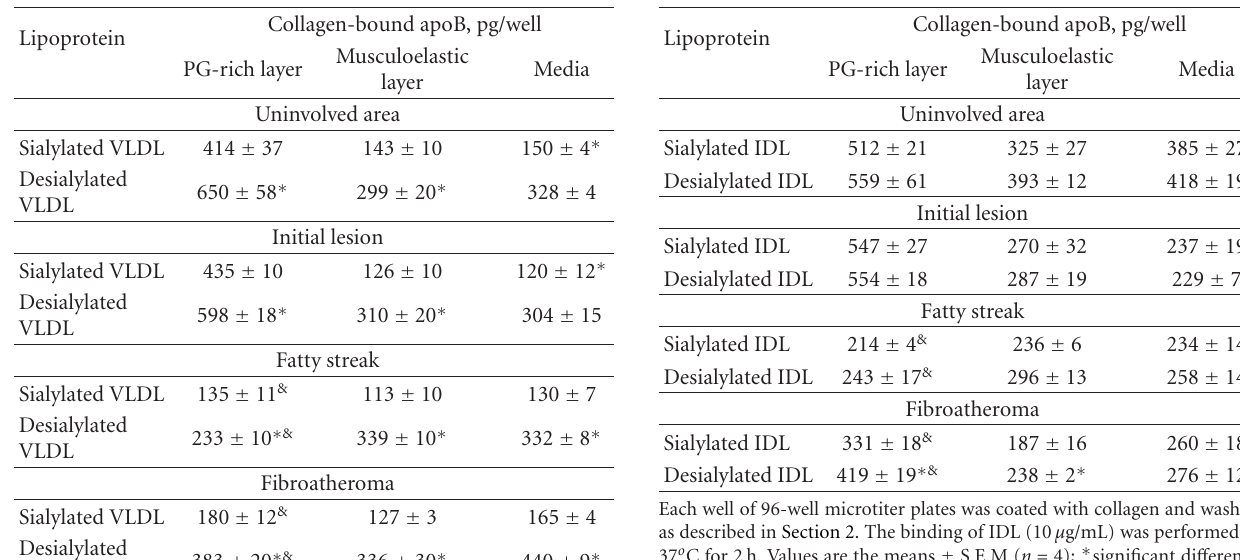
Table 1: Binding of sialylated and desialylated VLDL to collagen isolated from two layers of the intima and the media of uninvolved and atherosclerotic areas of human aorta.